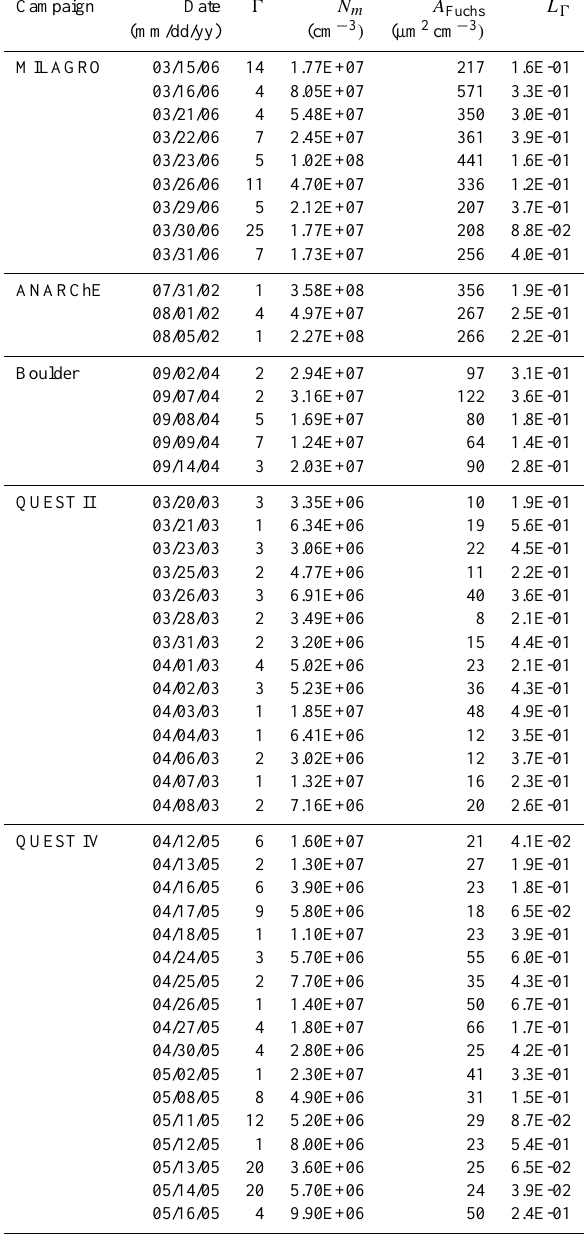
Table 1. Summary of relevant model parameters derived from measured aerosol size distributions and sulfuric acid concentra- tions for seventy-seven NPF events acquired during the MILAGRO (Tecamac), ANARChE (Atlanta), Boulder, QUEST II (Hyyti¨al¨a), QUEST IV (Hyyti¨al¨a), and EUCAARI (Hyyti¨al¨a) measurement campaigns. See text for parameter descriptions and